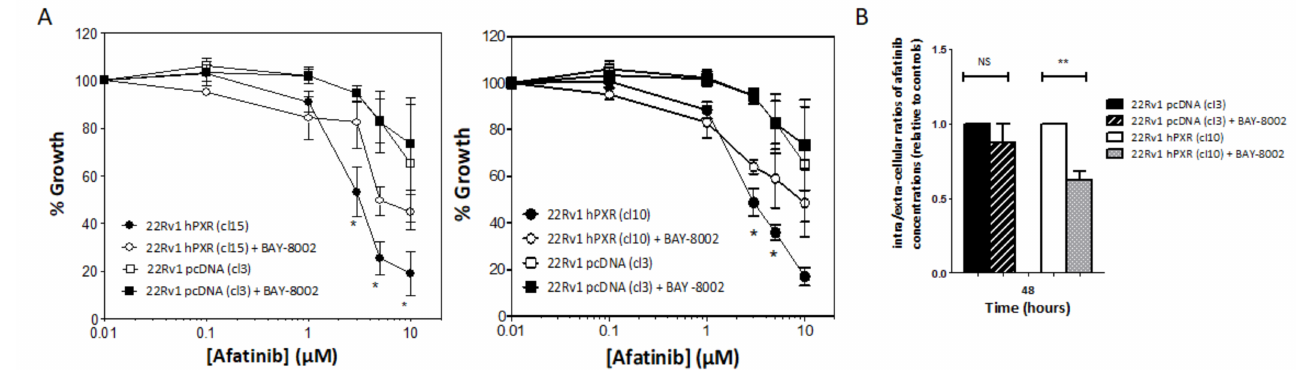
Figure 6. Inhibition of SLC16A1 alters PXR-mediated response of 22Rv1cells to afatinib. ( A ) Effects of the SLC16A1 inhibitor BAY-8002 on the sensitivity of the control clone compared with 22Rv1 clones 15 (left panel) and 10 (right panel) stably expressing PXR to afatinib. Cells were treated in the absence or in the presence of 10 µ M BAY-8002 and indicated concentrations of afatinib for 72 h and cell growth was evaluated using sulforhodamine B. Results are plotted as percentage of cell growth relative to untreated cells. ( B ) Effects of BAY-8002 on intracellular accumulation of afatinib. Control clone and 22Rv1 clone 10 were treated with 1 µ M afatinib in the absence or in the presence of 10 µ M BAY-8002 for 48 h and afatinib concentrations were measured using mass spectrometry as detailed in the Materials and Methods section. The results are expressed as intracellular/extracellular ratios of afatinib concentrations and normalized to untreated clones. Results are the mean ± SEM of at least 3 independent experiments. Statistical analysis was carried out using Student’s t -test and considered statistically significant for p < 0.05 (*) or p < 0.001 (**),